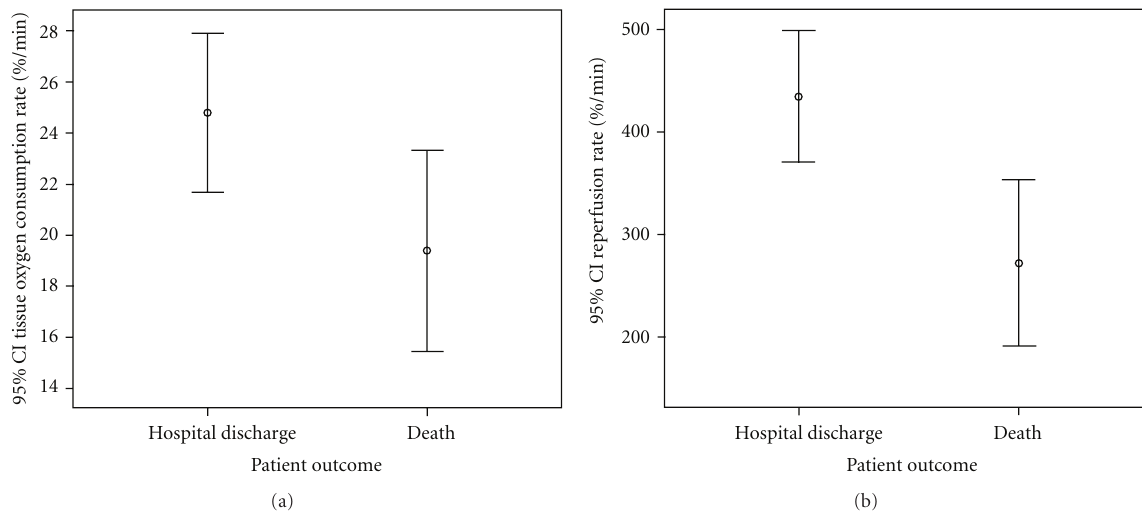
Figure 3: (a) Error bar of the thenar tissue O 2 consumption rate (%/min) during a 3min vascular occlusion technique in patient’ measurements who survived to hospital discharge and patients who died, for pooled data ( P < 0 . 05). (b) Error bar of the reperfusion rate (%/min) during a 3min vascular occlusion technique in patient’ measurements who survived to hospital discharge and patients who died, for pooled data ( P < 0 .